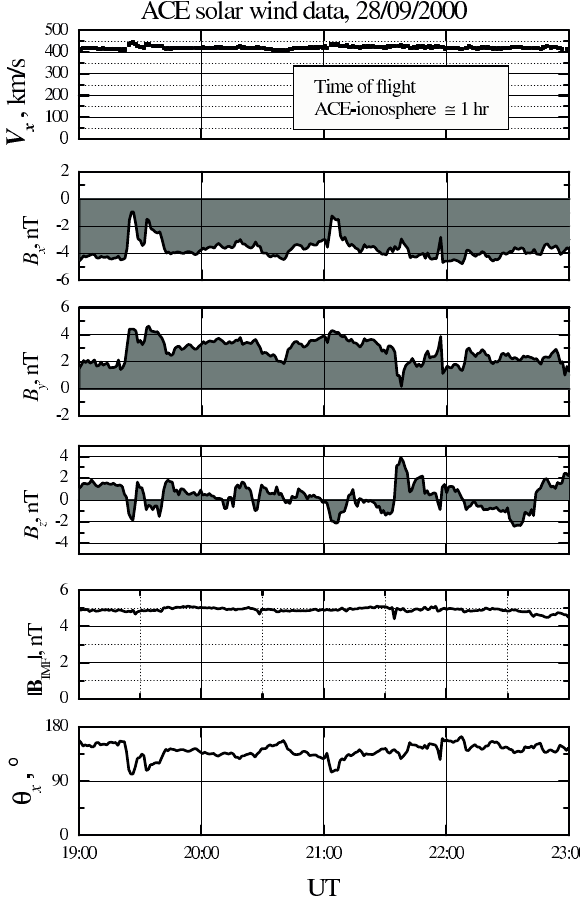
Fig. 3. Solar wind speed and IMF components from the ACE